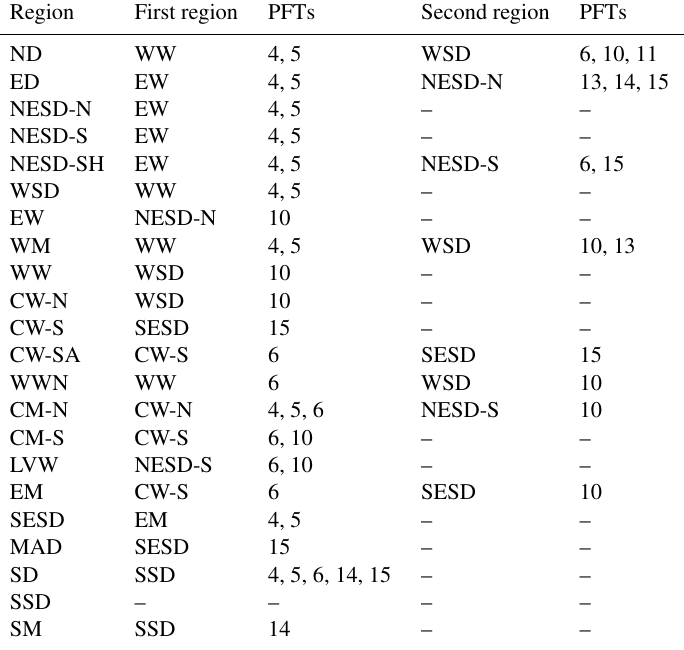
Table 4. Regional interpolation of missing PFT data.